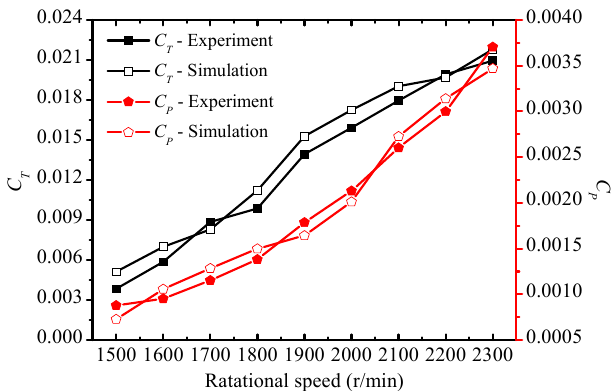
Figure 9. Comparison of C T and C P in experiment and simulation.